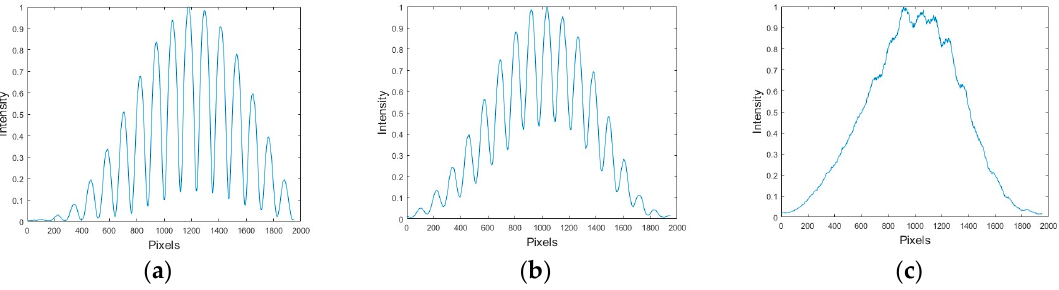
Figure 5. Intensity profiles as a function of pixels (length) obtained through a computer analysis of the